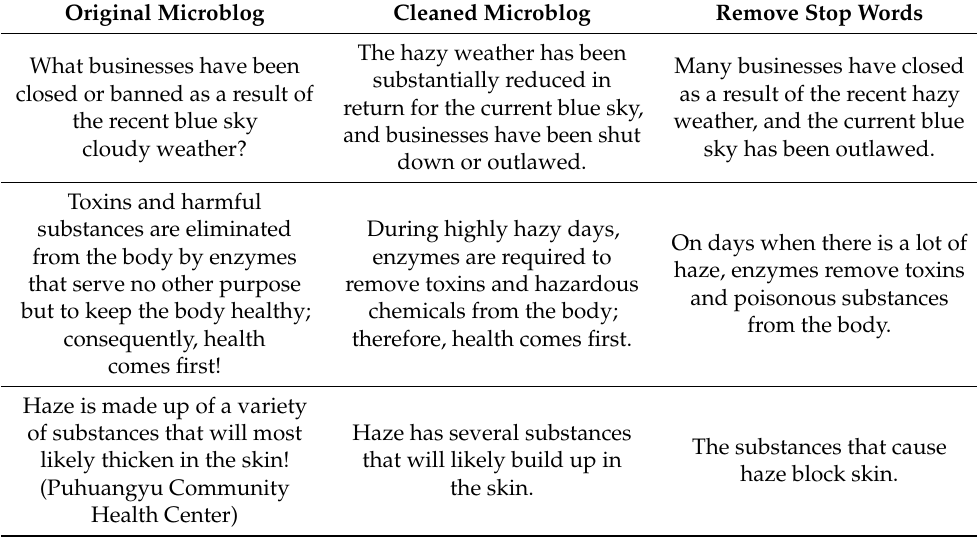
Table 1. Text preprocessing on a